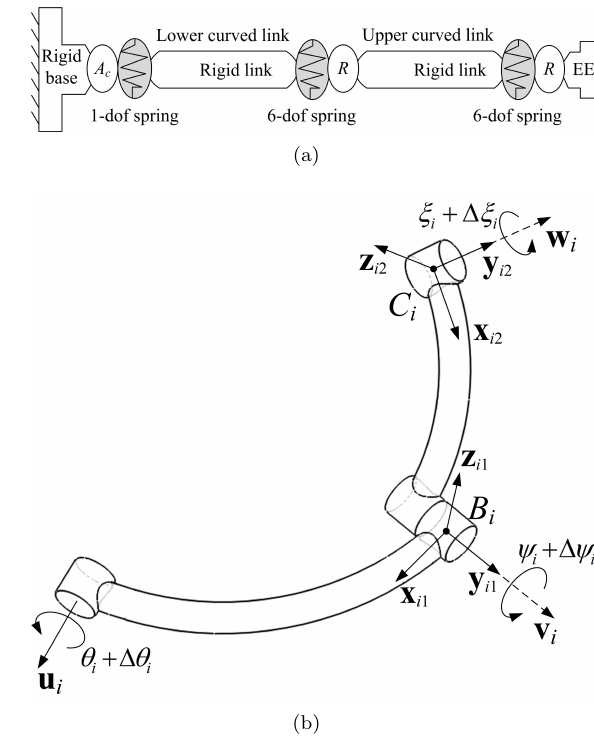
Figure 4: Flexibilities of one single leg: (a) virtual spring model, where A c stands for the actu- ator, R for revolute joints; (b) joint displace- ments in the i th leg in local